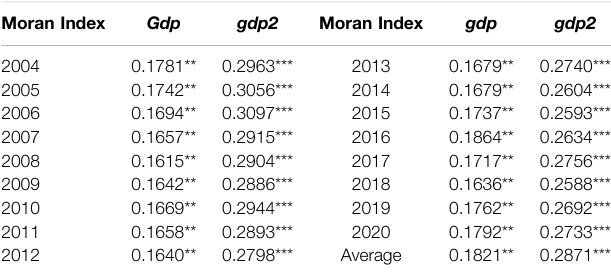
TABLE 3 | Results of Moran ’ s I test.